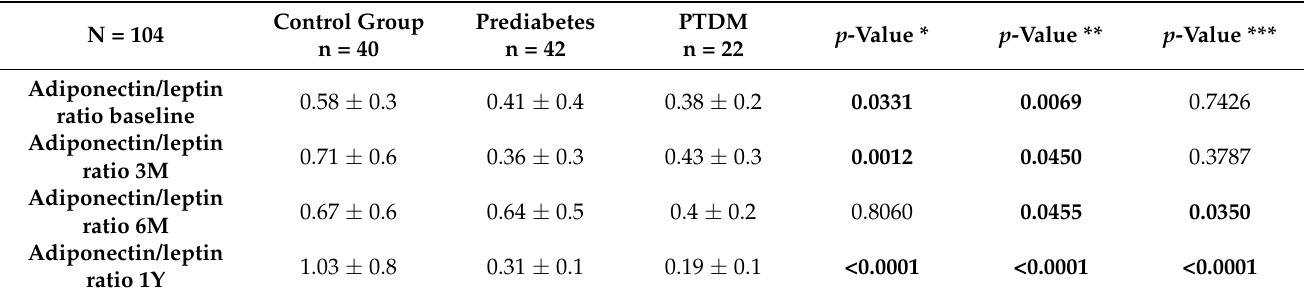
Figure 2. Development of the A/L ratio in observed group during the monitored period. NS — non- significant, M — month, Y — year, PTDM — post-transplant diabetes mellitus.